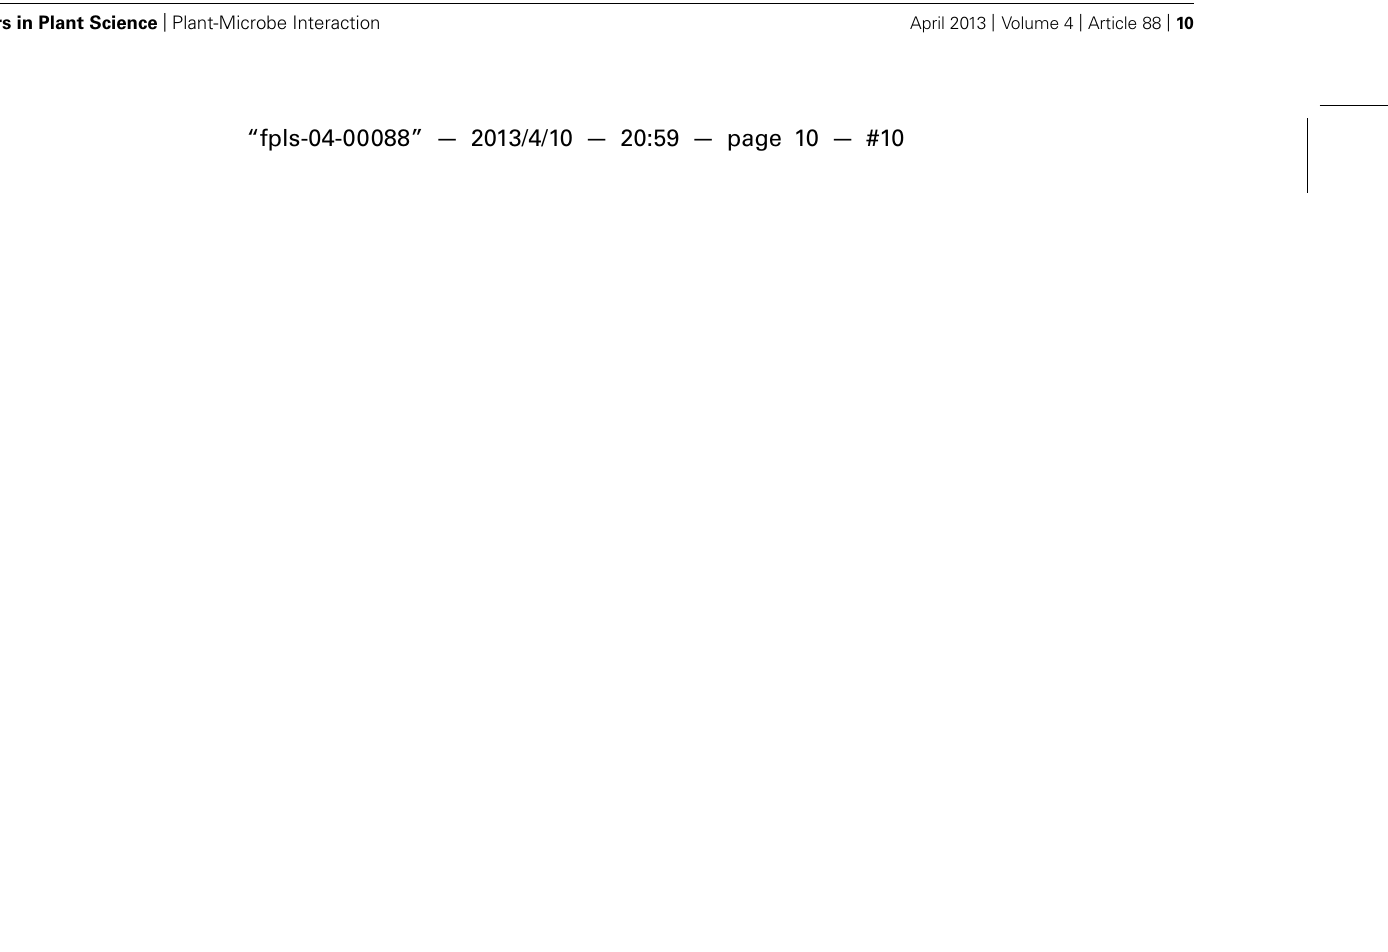
formation of ternary protein complexes comprising GBD-NIMIN1 or GBD-NIMIN2, GAD-AtTGA2 or GAD-AtTGA6 and At NPR1.The binary interactions of At NPR1 with NIMIN1 or NIMIN2 orTGA2 serve as controls for effects of SA (concentration 0.3 mM) on the NPR1–NIMIN1/2